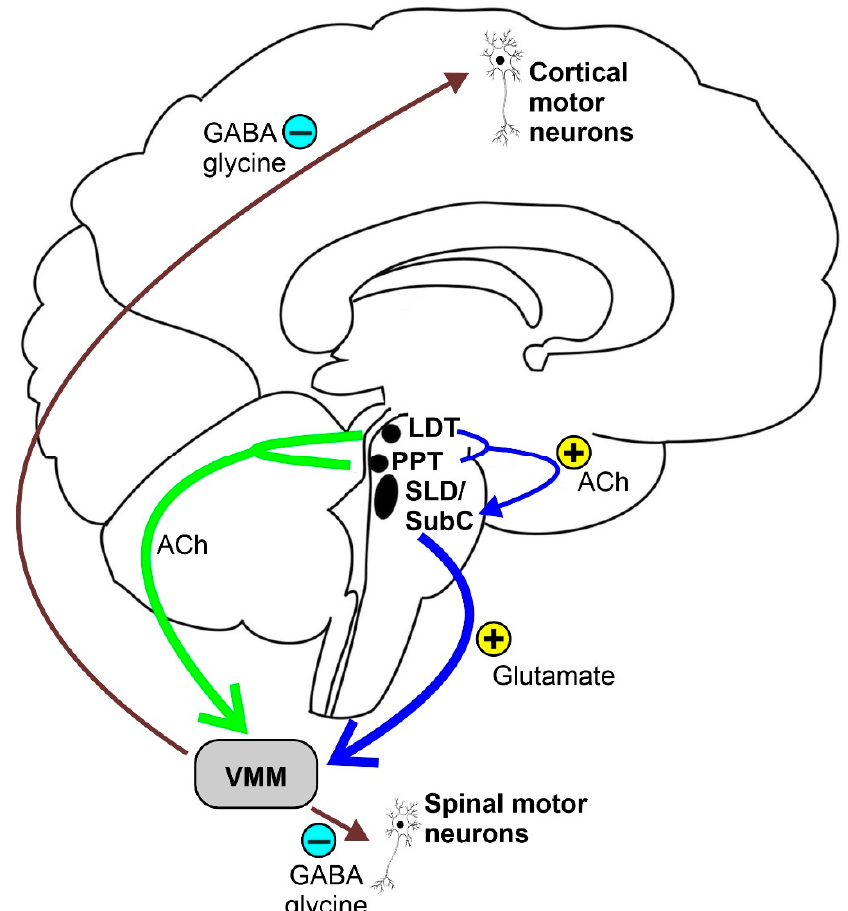
Figure 1. Schematic representation of the REM sleep atonia circuitry. Ach = acetylcholine, LDT = laterodorsal tegmental nucleus, PPT = pedunculopontine nucleus, SLD = sublaterodorsal tegmental nucleus, SubC = subcoeruleus nucleus, and VMM = ventromedial medulla. Some studies suggest a cholinergic modulation of REM paralysis circuitry [35].